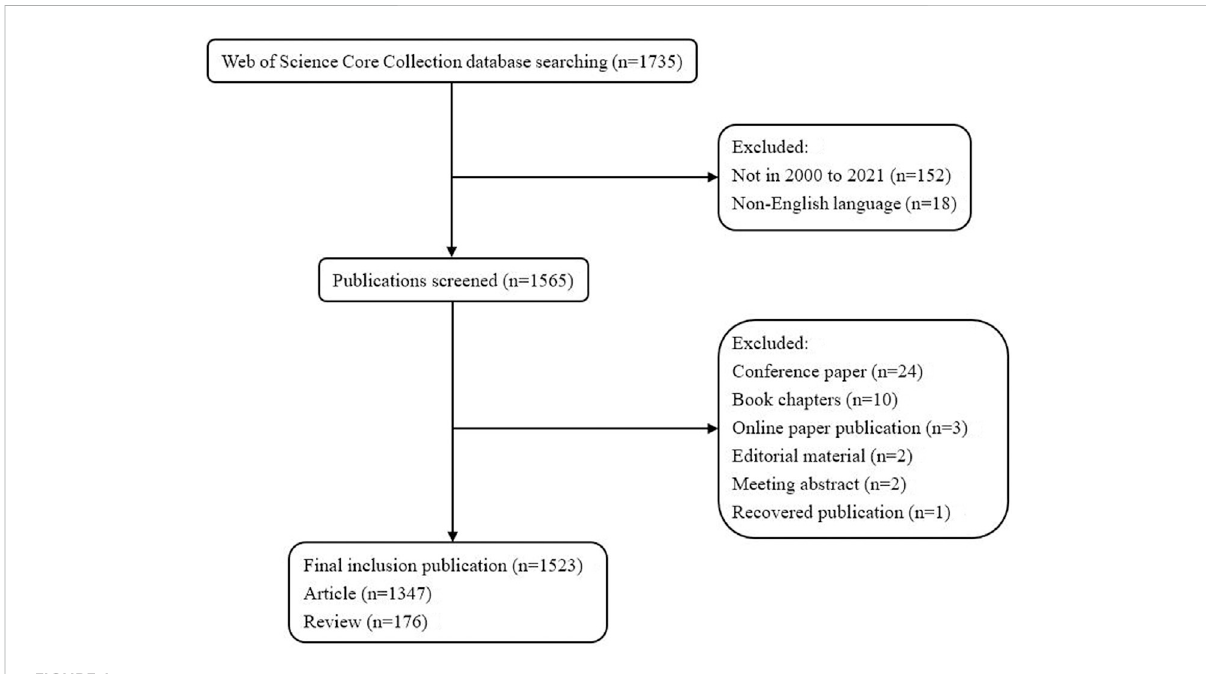
FIGURE 1 Flowchart of data screening and